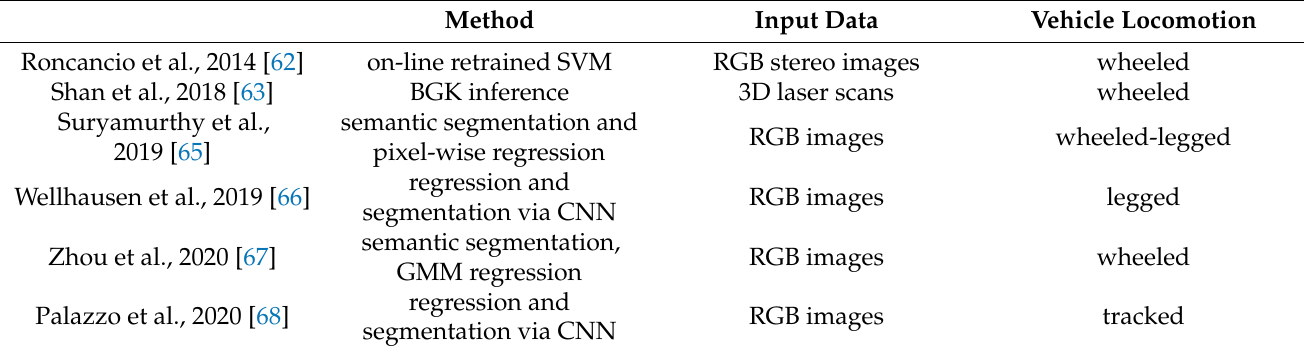
Table 5. Mixed classification/regression methods for terrain